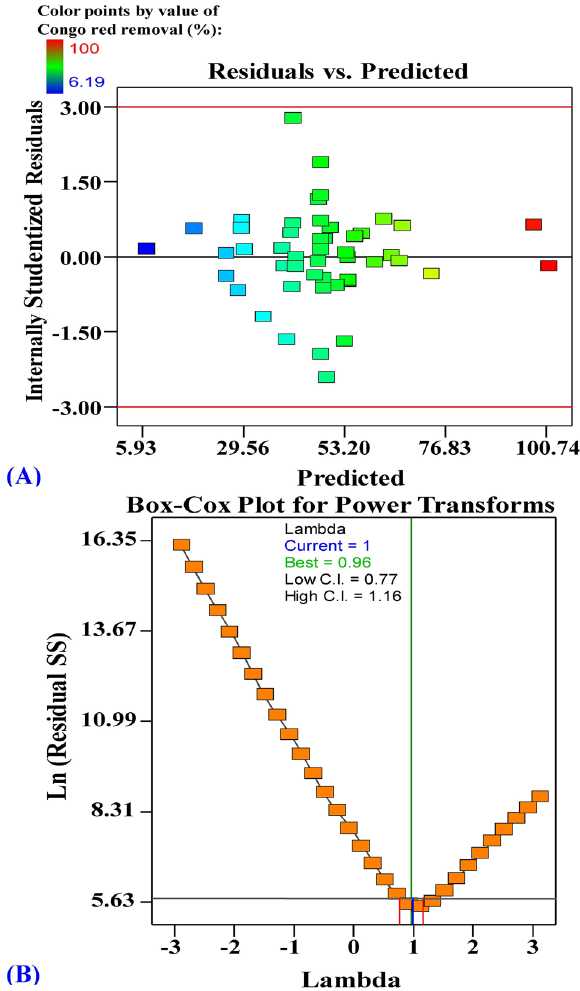
Figure 3. ( A ) Plot of internally studentized residuals versus predicted values and ( B ) Box- Cox plot of model transformation of Congo red biosorption by E.